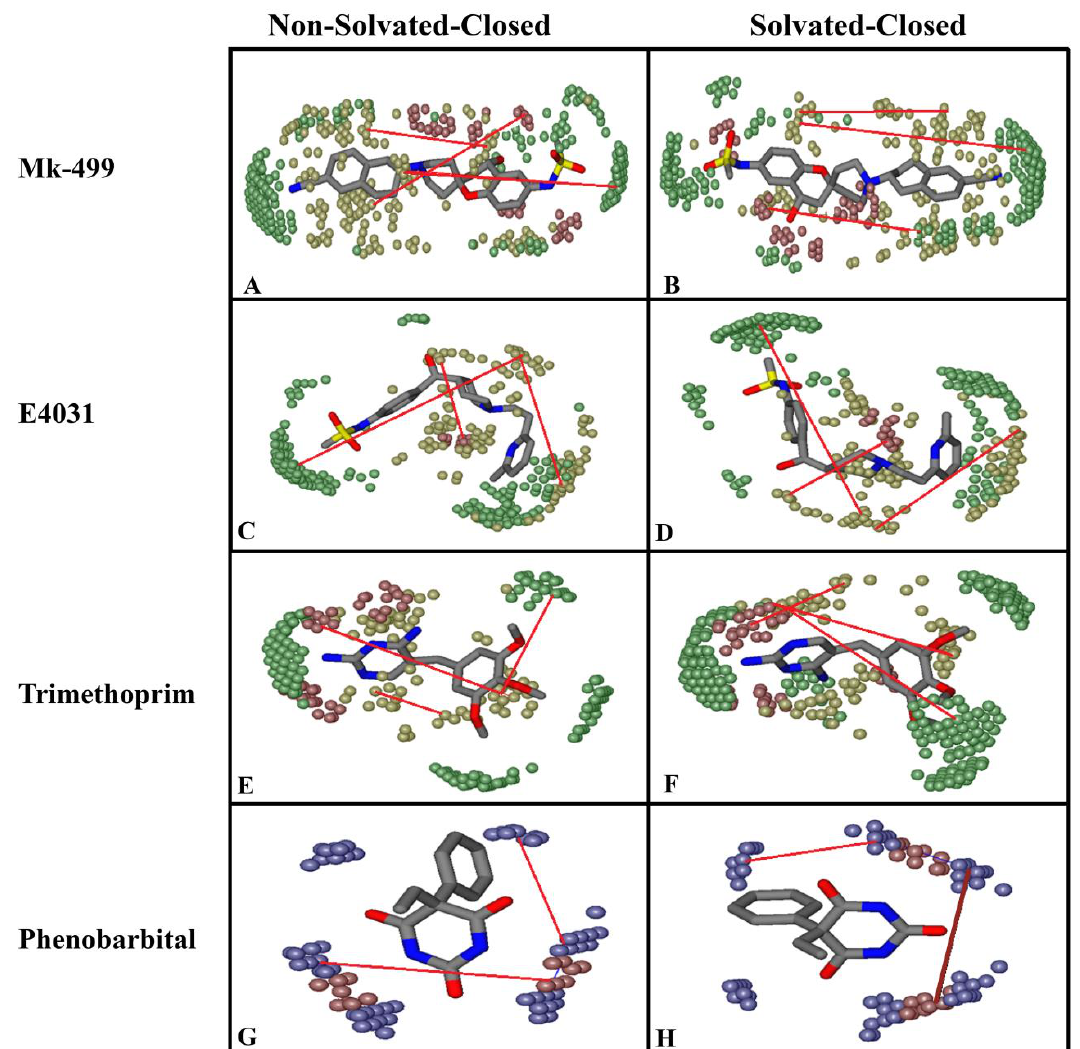
Figure 12. Comparison of important hotspots regions in closed non-solvated and solvated GRIND model. Red lines represent the respective distance between the two features. DRY-DRY (yellow hotspots) shows the distance between two hydrophobic features DRY-TIP yellow and green respectively shown distance between hydrophobic feature and steric molecular boundary, DRY-O yellow and red shows the distance between hydrophobic group and hydrogen bond donor group positively contribute the hERG inhibitory potency and the features obtain from non-solvated and solvated conformations are almost similar. ( A ) MK-499 MIF of non-solvated-closed state and their respective distances. ( B ) MK-499 MIF of solvated-closed state and their respective distances. ( C ) E4031 MIF of non-solvated-closed state and their respective distances. ( D ) E4031 MIF of solvated-closed state and their respective distances. ( E ) Trimethoprim MIF of non-solvated-closed state and their respective distances. ( F ) Trimethoprim MIF of solvated-closed state and their respective distances. Likewise ( G ) phenobarbital in non-solvated-closed state and their respective distances. ( H ) Phenobarbital in solvated-closed state and their respective distances shows N1-N1 blue hotspots shows two hydrogen bond acceptor feature and O-NI red and blue hotspot represent if this feature present at a particular distance will impact negatively towards biological potency of hERG inhibitors.